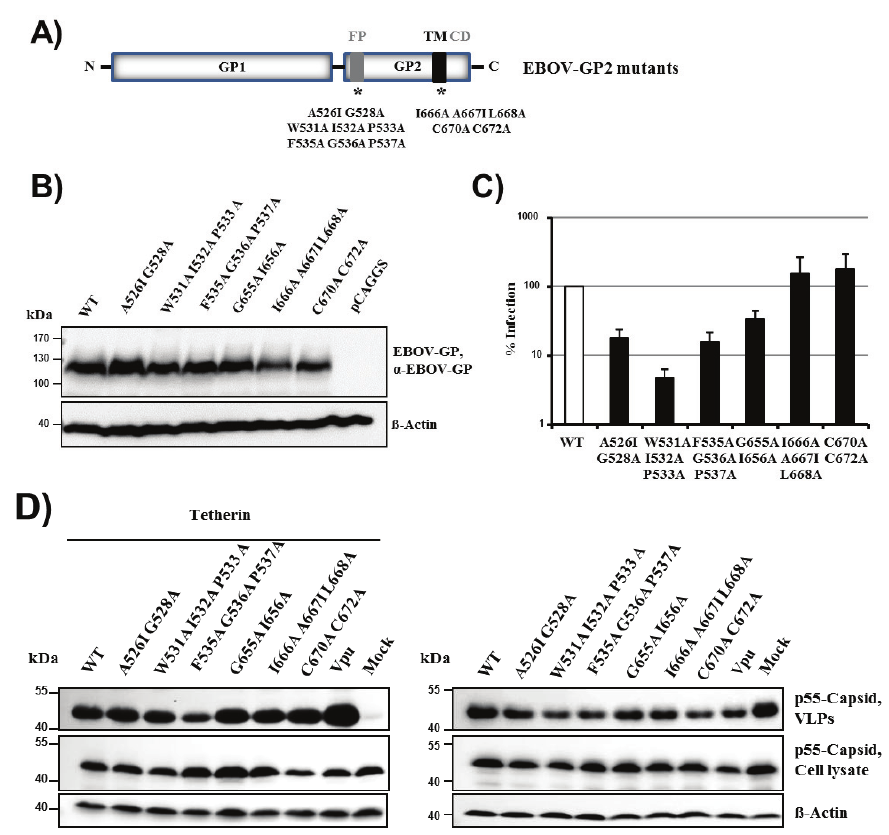
Figure 1B. Transduction mediated by EBOV-GP wt was set as 100%. The average of five individual experiments is shown. Error bars indicate SEM. ( D ) Tetherin antagonism of the EBOV-GP mutants was analyzed as described for Figure 1C. A representative experiment is shown. Similar results were obtained in five separate